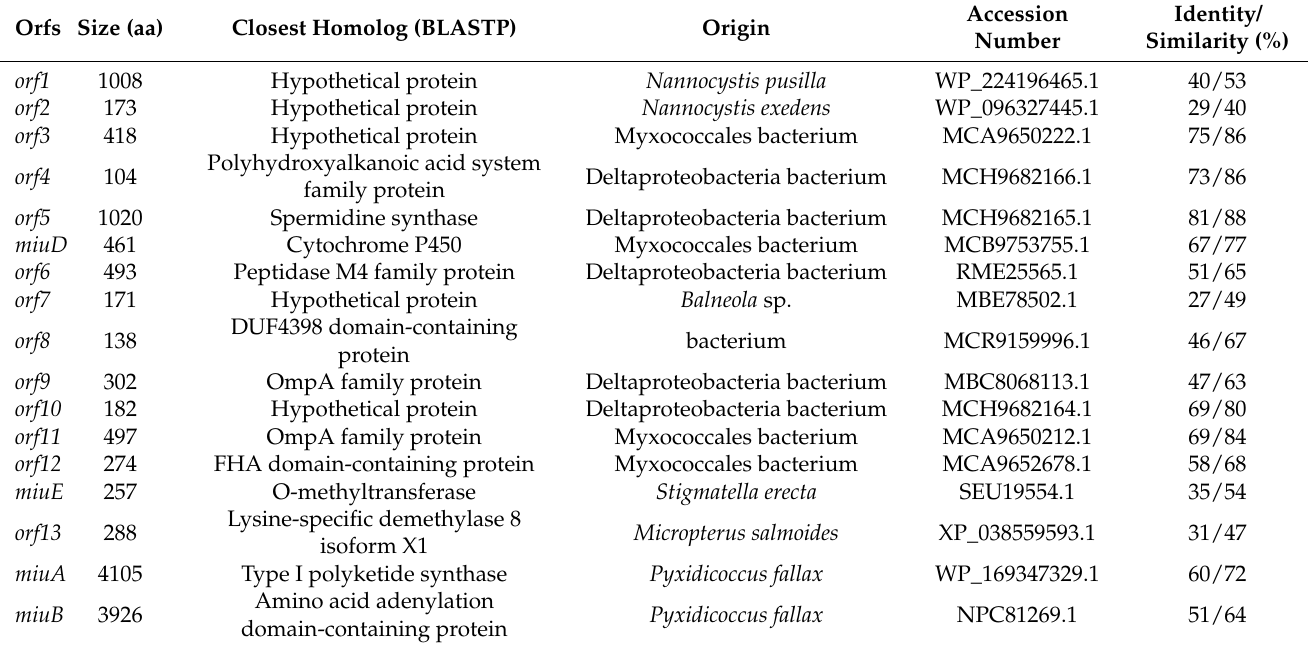
Table 1. Predicted functions of the orfs in the miu cluster-containing region (Figure